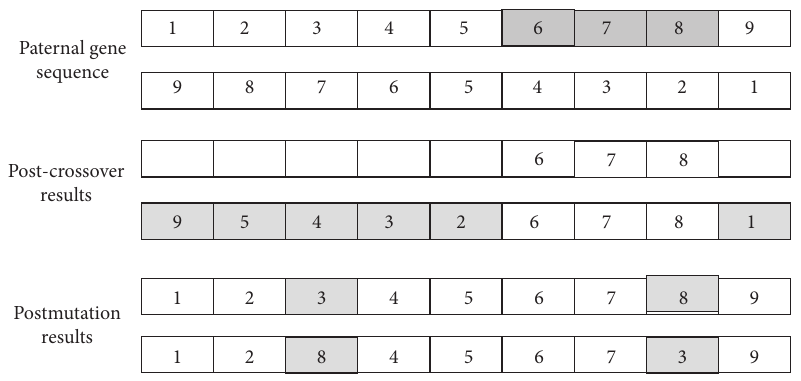
Figure 2: Gene crossover and